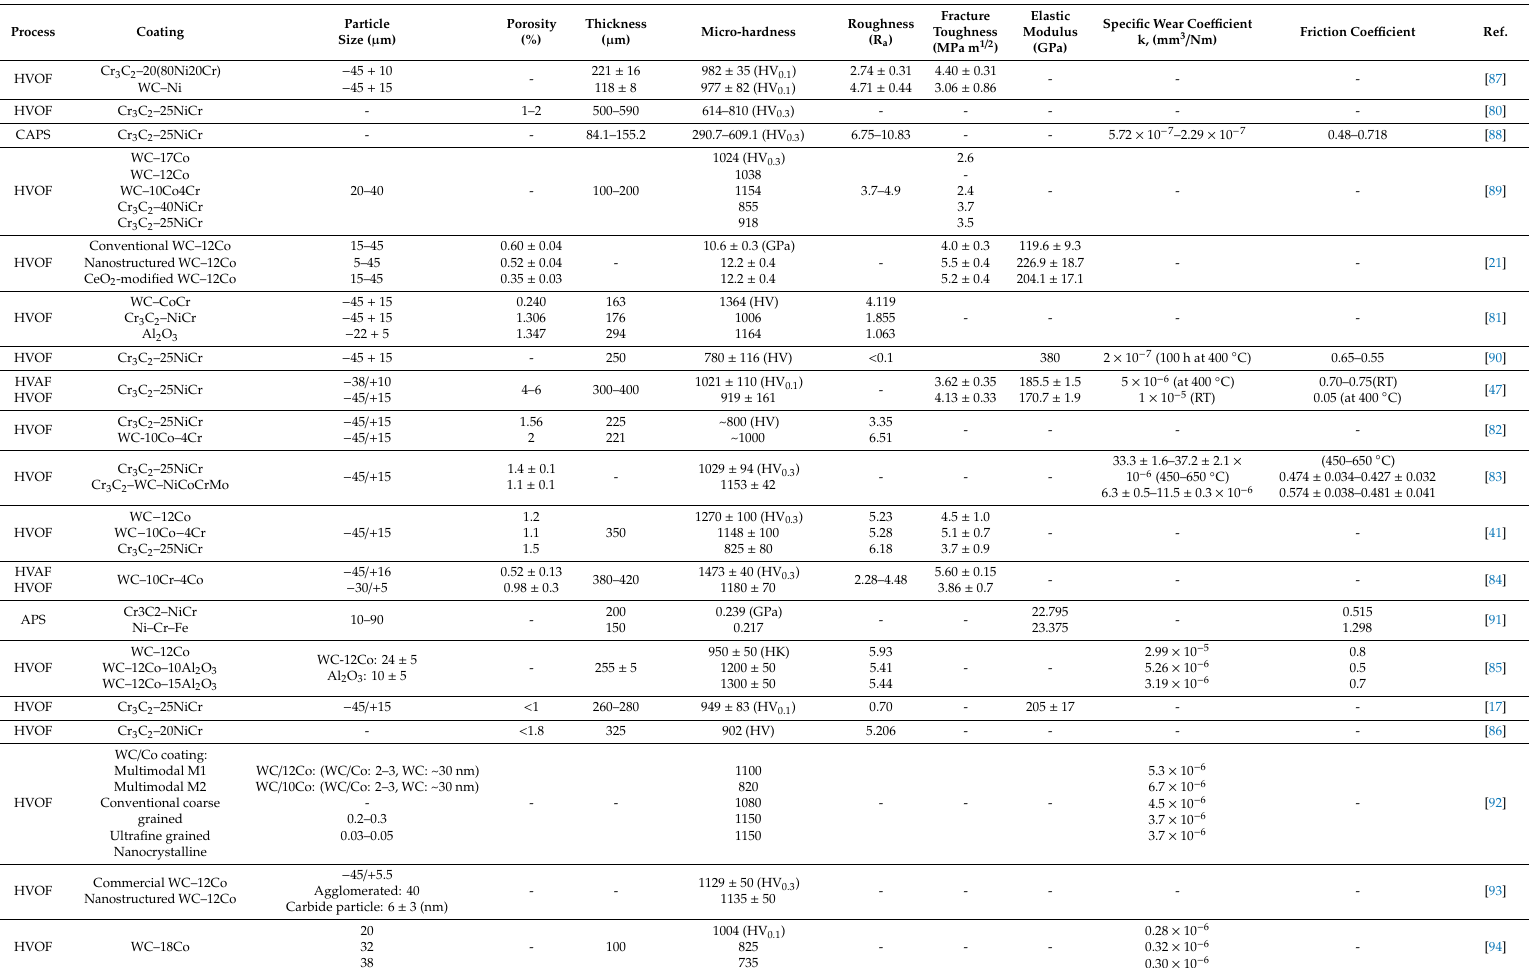
Table 1. Mechanical and wear behavior of the reported